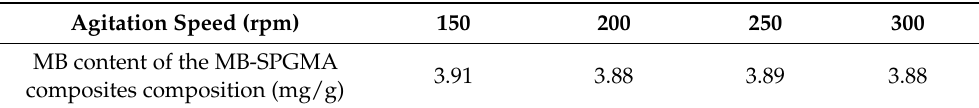
Table 3. Effect of agitation speed on the MB content of the MB-SPGMA composites composition.